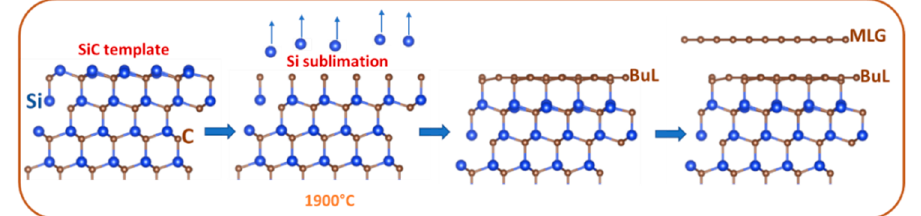
Figure 1. The experimental steps leading to the formation of monolayer epitaxial graphene on SiC. This scheme has been adapted with permission from [42]. Copyright 2021 The Authors. Published by American Chemical Society (ACS), Washington, United States. Further permissions related to the material excerpted should be directed to the ACS, Washington, United States.